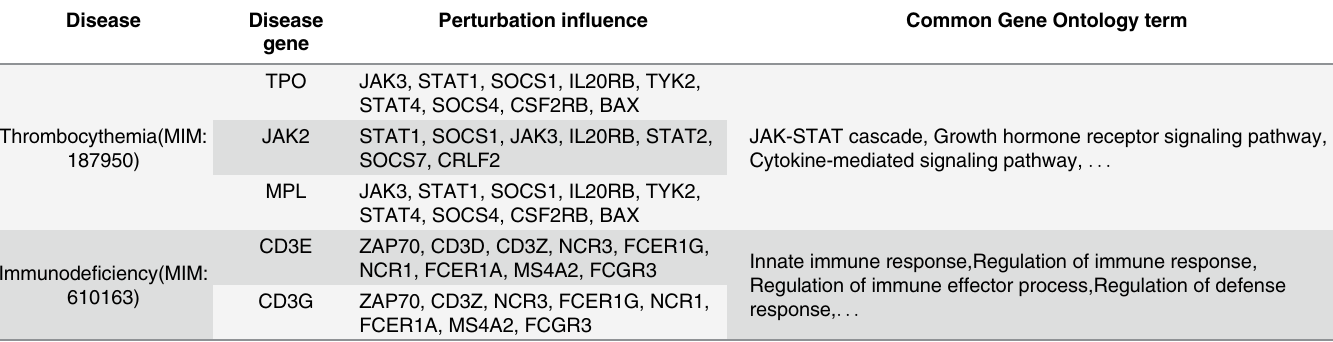
Table 1. Instances for the perturbation influence of disease gene.